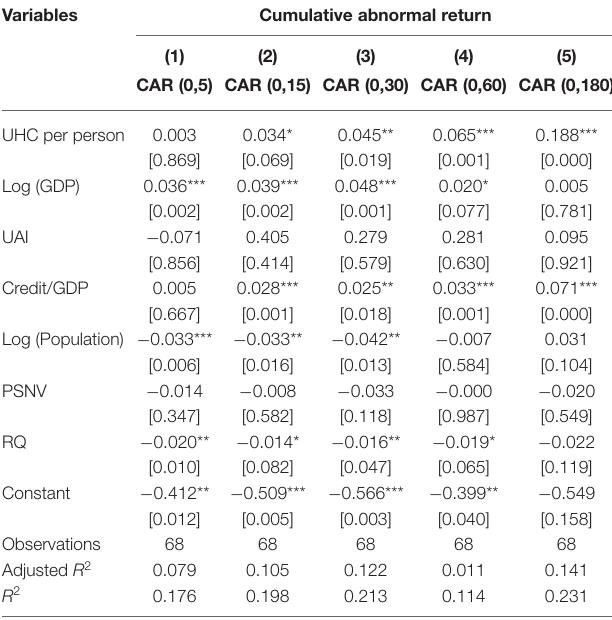
TABLE 5 | Results of direct impact of UHC on cumulative abnormal